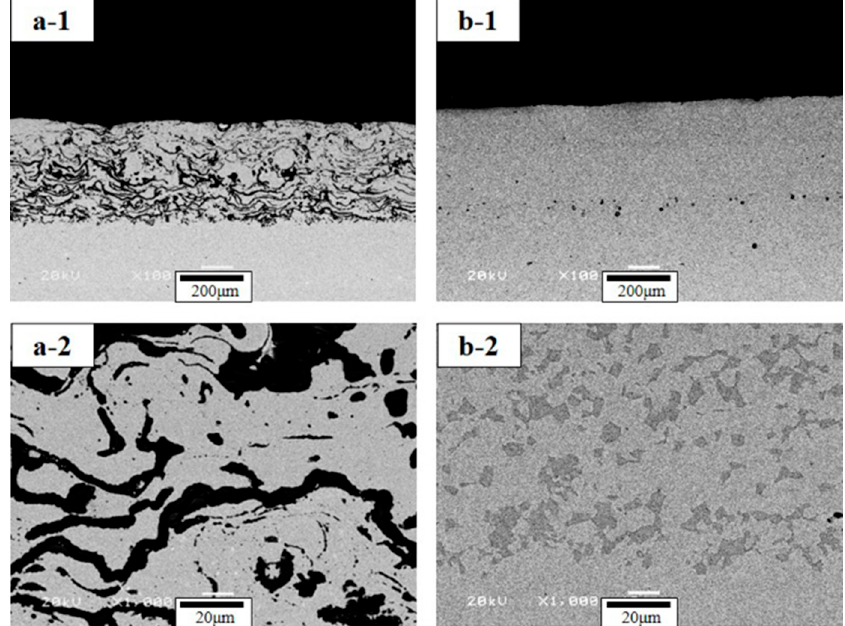
Figure 3. Cross-sectional microstructures of TBCs after CFTF tests: TBC with APS bond coat (the overall ( a–1 ) and the interface ( a–2 ) microstructures) and TBC with HVOF bond coat (the overall ( b–1 ) and the interface ( b–2 ) microstructures).